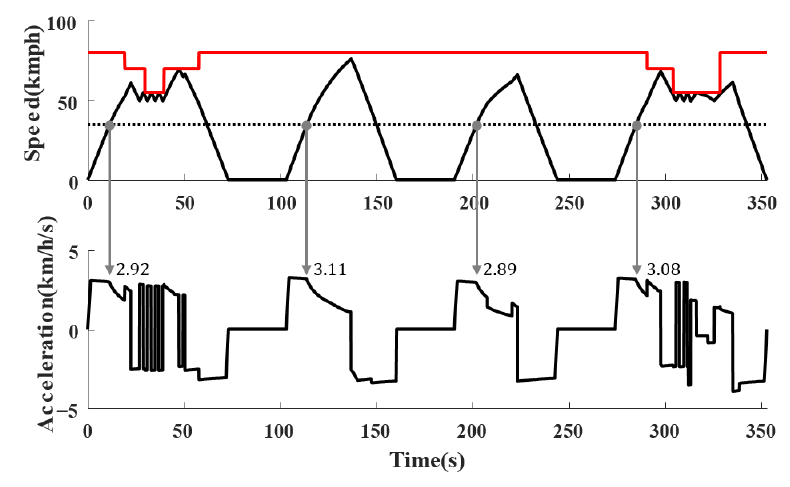
Figure 10. Train speed and acceleration result in time;section between substation A and